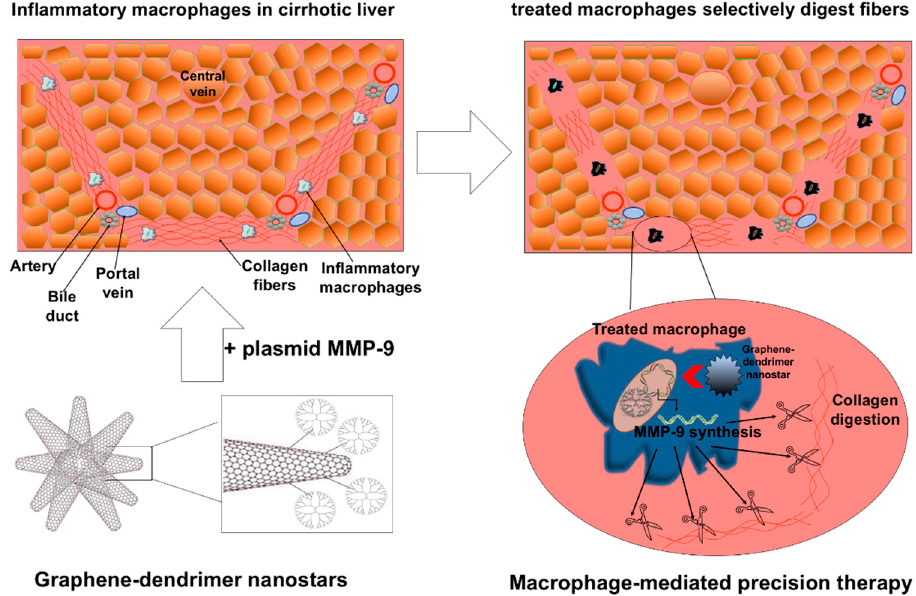
Figure 4. Targeted gene therapy with Graphene-dendrimer nanostars formed by SWCNH. Plasmid metalloproteinase 9 (MMP-9) is selectively delivered into inflammatory macrophages in cirrhotic liver by dendrimer-graphene nanostars allowing the synthesis and excretion of a functional MMP-9 to digest adjacent collagen fibers. Reprinted with permission from [21] (Melgar-Lesmes, P.; et al. Graphene-Dendrimer Nanostars for Targeted Macrophage Overexpression of Metalloproteinase 9